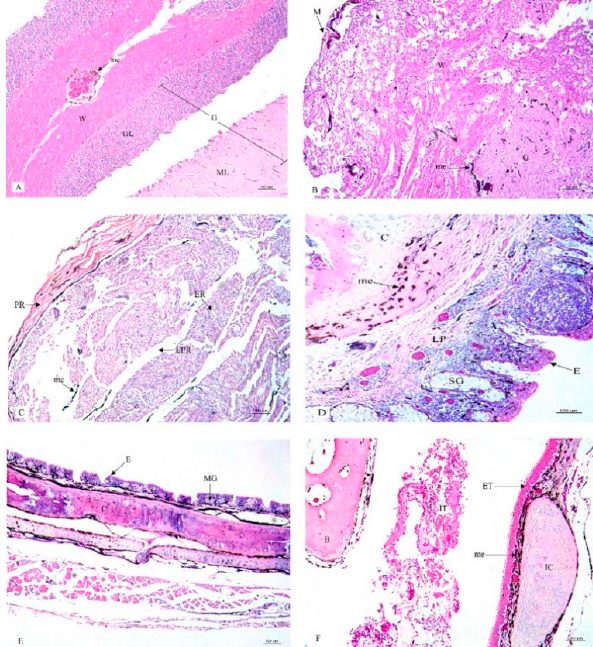
Figure 1. Histological location of melanin pigment in each organ; brain ( A ), spinal cord ( B ), sciatic nerve ( C ), larynx ( D ), trachea ( E ), syrinx ( F ). Abbreviations: M, meninges; G, gray matter; W, white matter; GL, granular layer; ML, molecular layer; PR, perinurium; ER, endonurium; EPR, epinurium; E, epithelium; LP, lamina propria; MG, mucous gland; C, cartilage; SG, seromucous gland; ET, external tympanic membrane; IT, internal tympanic membrane; IC, intermediate syringeal cartilage; B, bony pessulus;, me, melanin pigment. Low magnification, H&E stain.